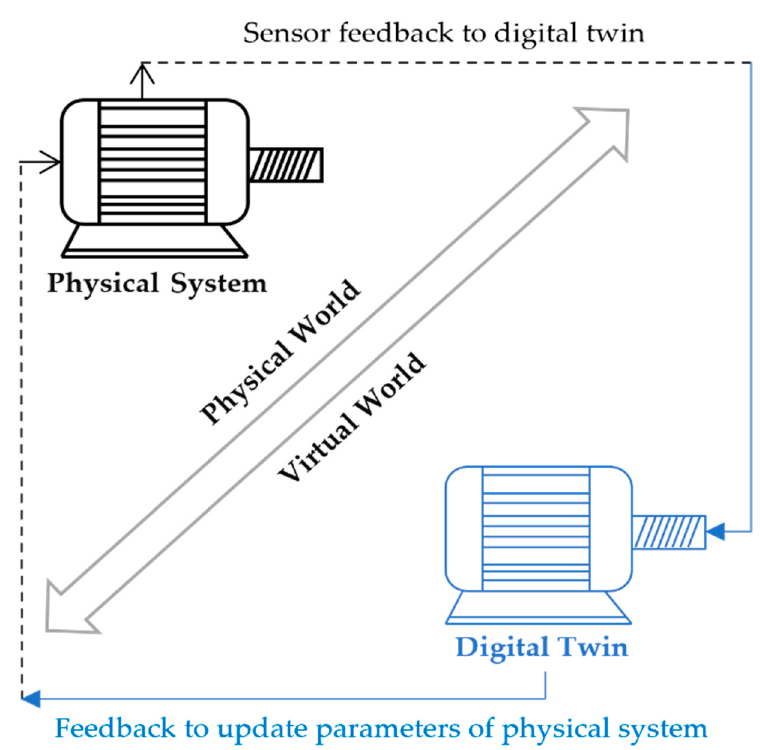
Figure 2. An abstract representation of the digital twin (DT) model of a motor. A DT model recreates real-world entities in a virtual environment with the exact characteristics of the real system. With the information from the sensors, the virtual model will reproduce the exact state and condition of the real-world system.